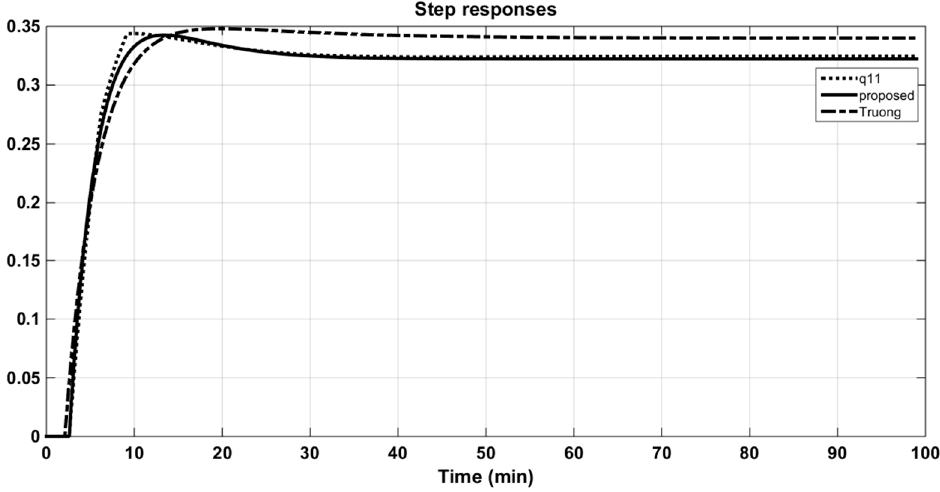
Figure 18. Step responses of the original q 11 and its approximations (Ogunnaike and Ray (OR) column).